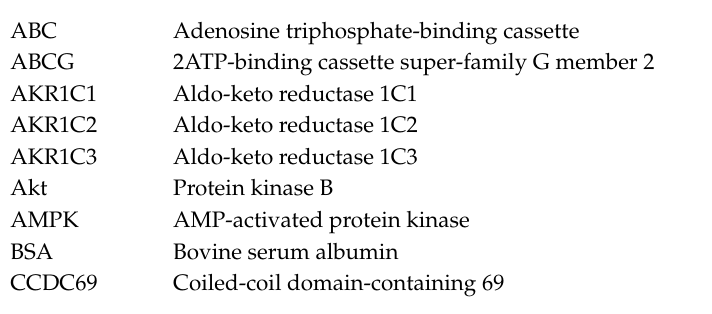
Figure S1. Cell viabilities and induction of apoptosis in MDA-MB-231 cells and MDA-MB-231/IR cells treated with irradiation or anti-cancer drugs, Table S1. IC 50 of phytochemical treatments on MDA-MB-231 cells and MDA-MB-231/IR cells. Table S2. CI value of combination treatments on MDA-MB-231/IR